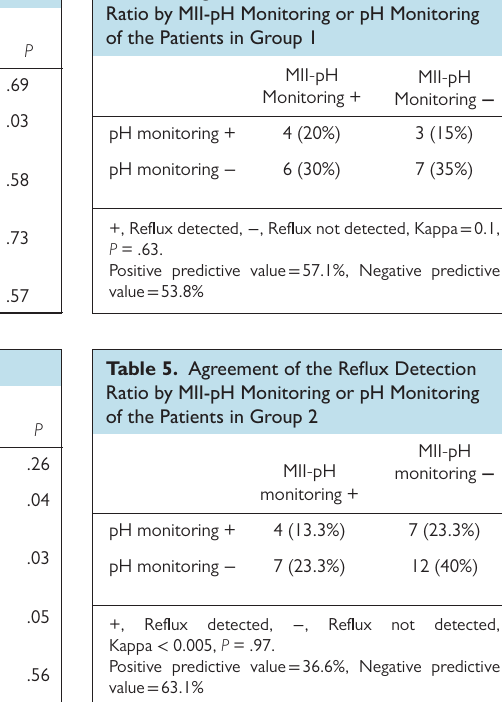
Table 2. Comparison of the Results of 24-hour pH Monitoring Parameters of the 2 Groups Group 1 [Median (Interquartile Results Range)]